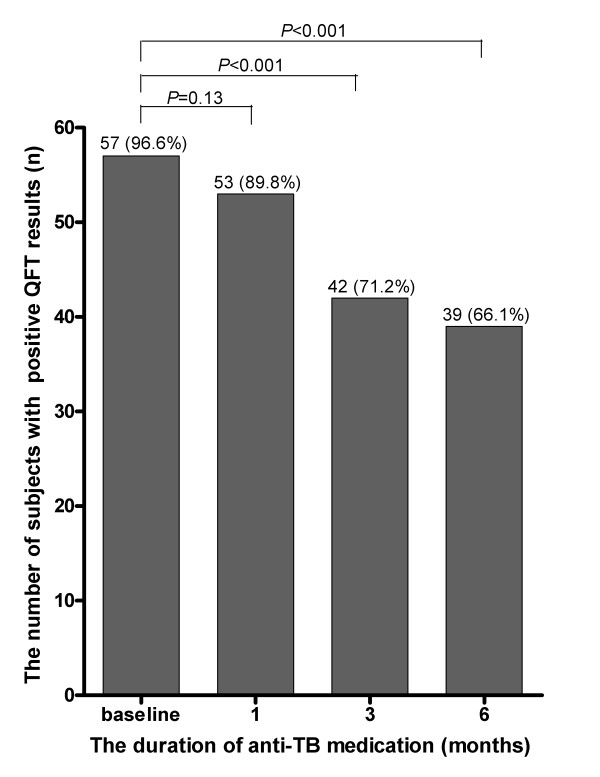
The proportion of active tuberculosis patients with positive QFT-GIT results.